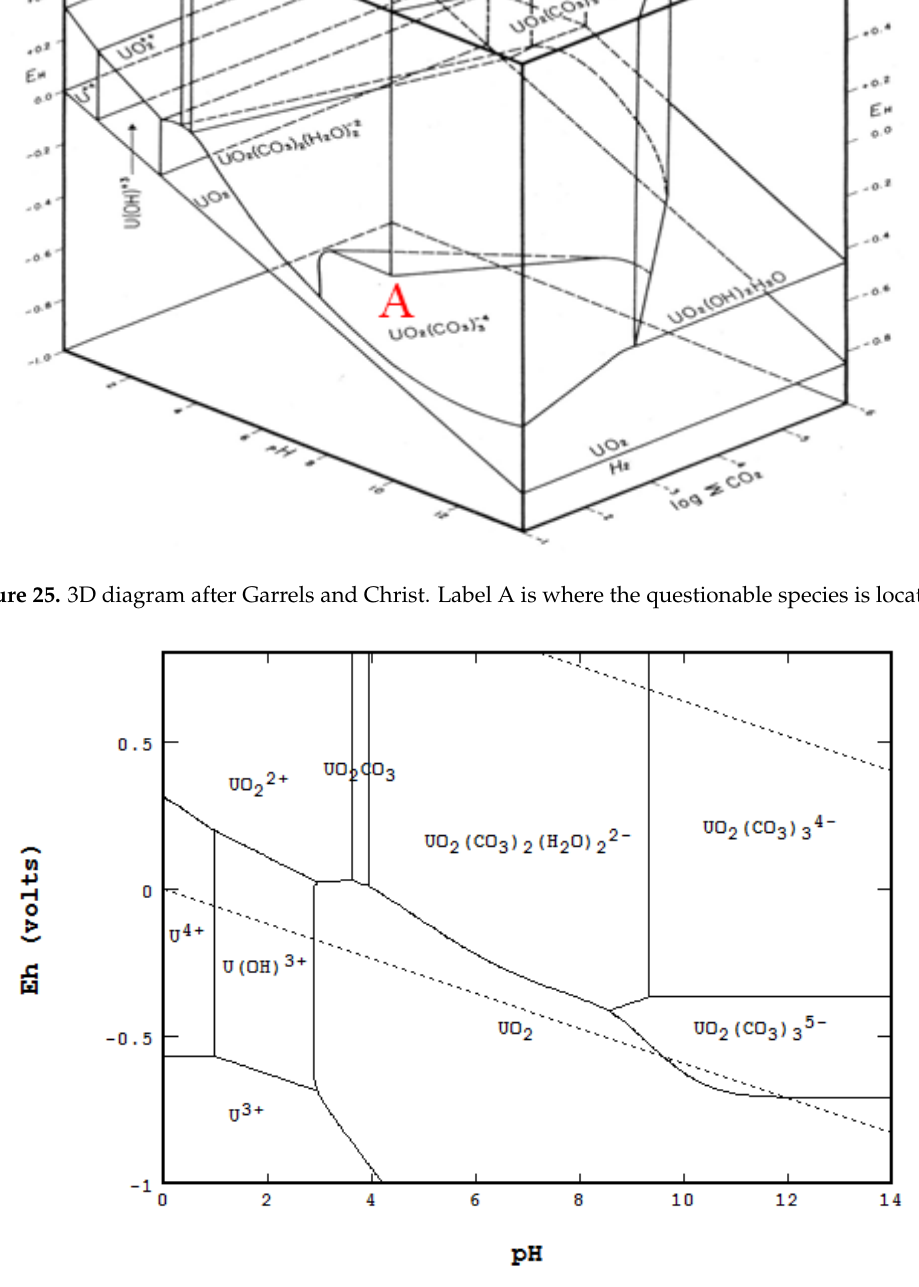
Figure 26. The Eh-pH diagram of U with log CO 2 = −1. The inclusion of UO 2 (CO 3 ) 35− clarifies a region that Garrels and Christ might have misrepresented.